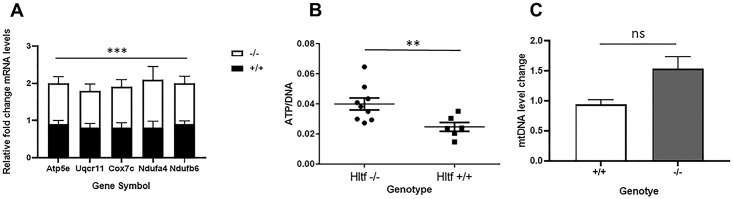
Gene expression and mitochondrial function.A. qRT-PCR confirmed upregulation of the five genes annotated to oxidative phosphorylation in tumors from Hltf-deleted (n = 23) compared to control (n = 14) mice. B. Total cellular ATP was normalized to DNA from Hltf-deleted (n = 8) and control (n = 8) samples that were assayed in duplicate. C. Mouse mitochondrial DNA copy number was determined by the comparison of mitochondrial (mt) and nuclear (n) DNA measured by qPCR. Of the 16 tumor samples from Hltf-deleted mice, the one sample that failed to amplify was excluded from the calculations. Values in each panel are expressed as mean±SEM, ***p≤0.001, **p≤0.01, non-significant (ns) = P>0.05.